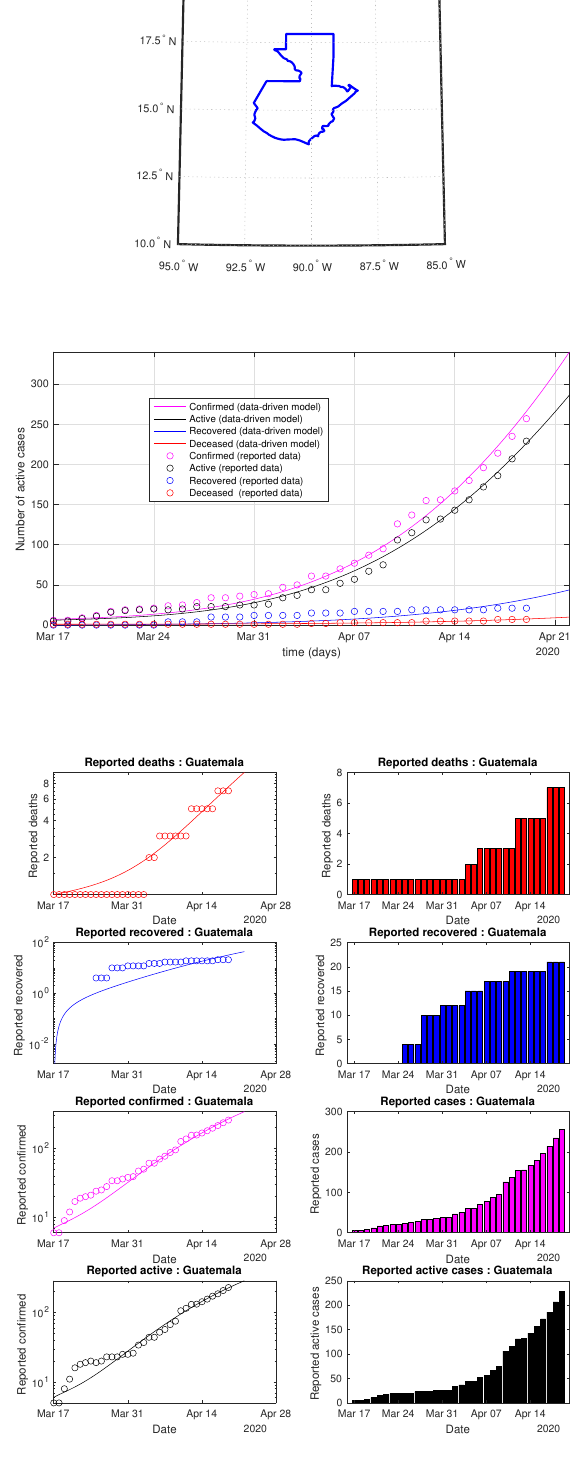
Figure 31. Guatemala: data of active, recovered, deceased (in circle or bar) vs. model of active, recovered, deceased over time. Tracking the number of active cases. Predictive analytics for the next couple